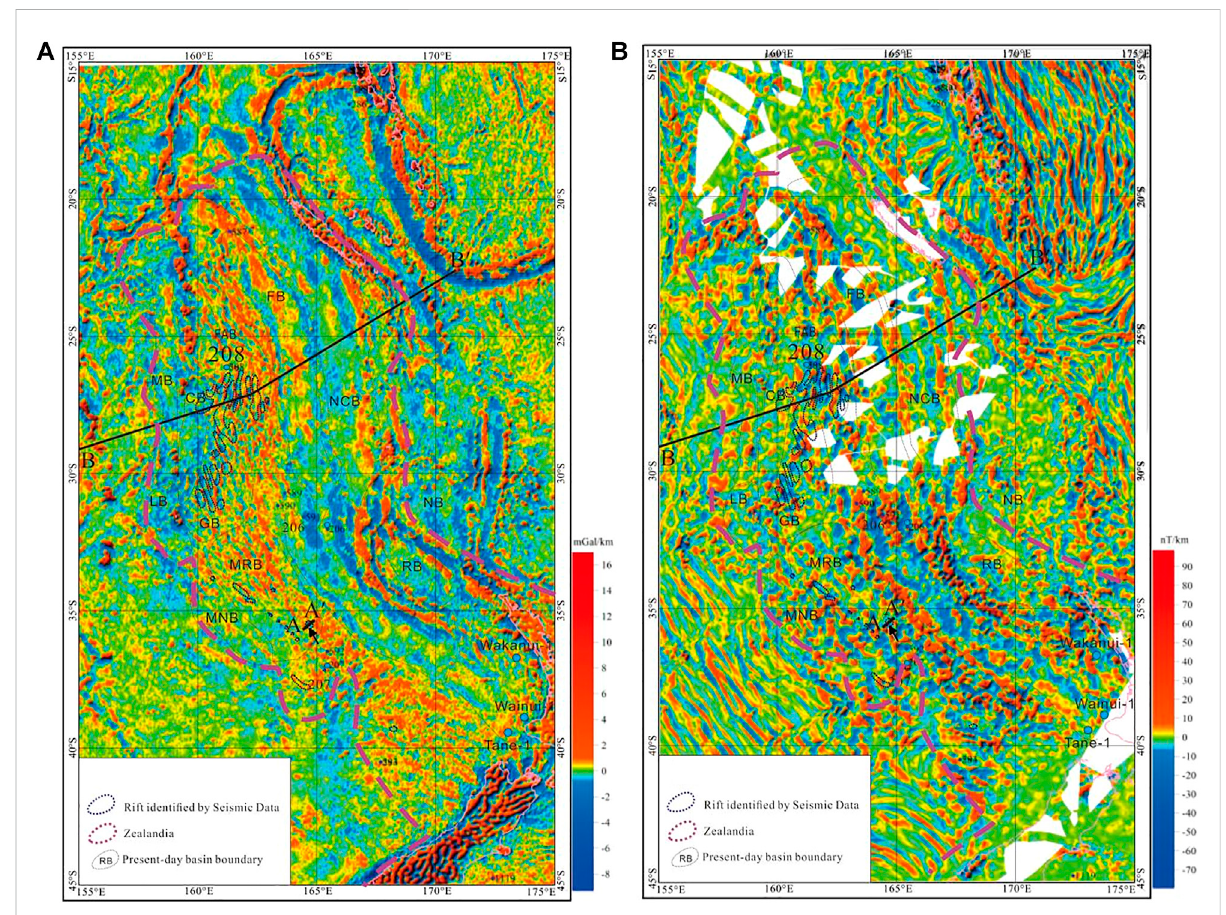
FIGURE 4 First-orderverticalderivativeof (A) gravityand (B) magneticanomalyreducedtothepole.Thesolidblacklinepointedbythewhitearrowlocates the position of the seismic section in Figure 3. (A) First-order vertical derivative of gravity anomaly. (B) . First-order vertical derivative of magnetic anomaly reduced to the pole. The white area is the data blank area. Abbreviation of basin name (see Figure